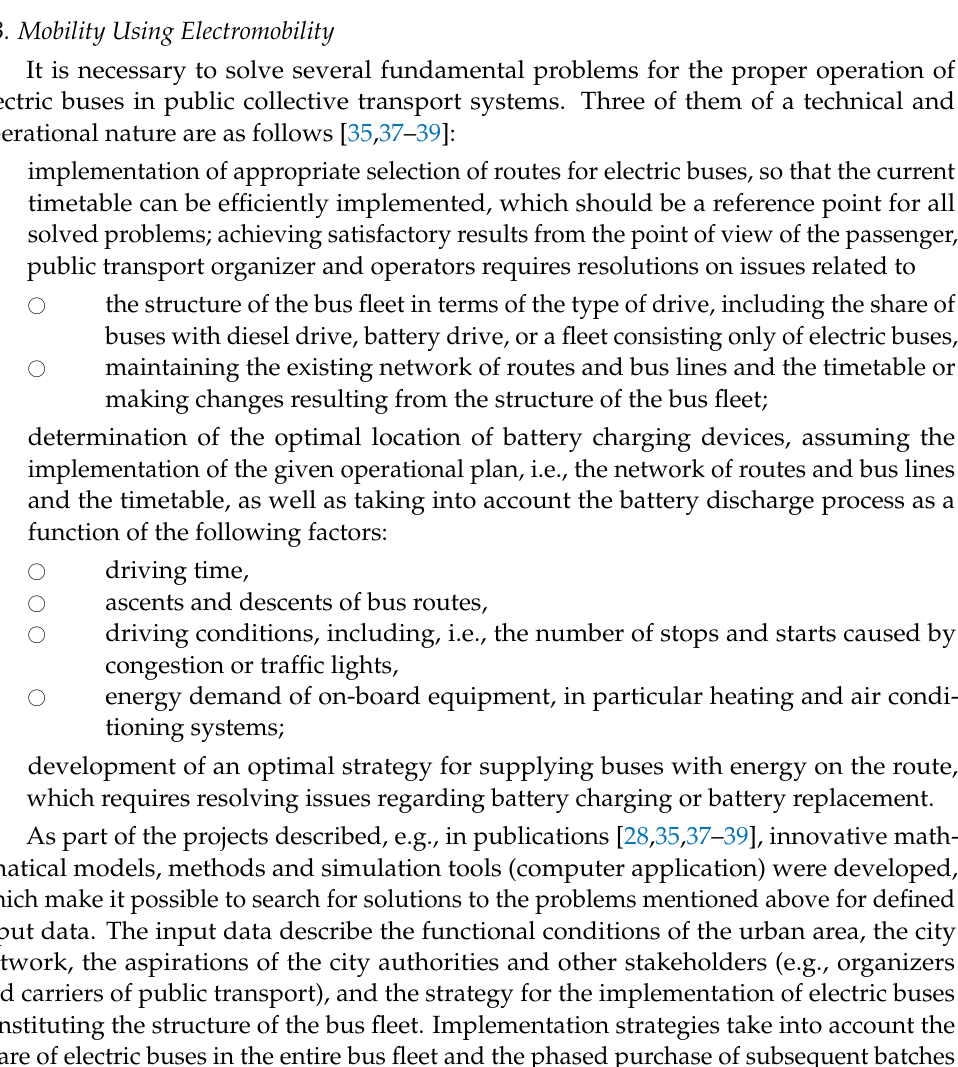
Figure 8. Changes in transport needs during the pandemic. Source: based on